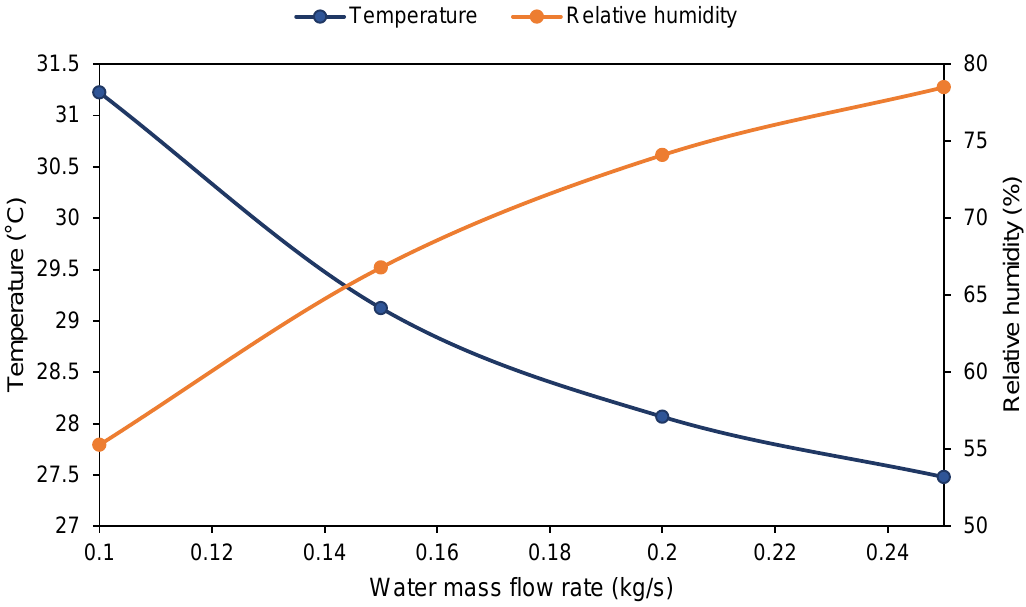
Figure 21. The influence of the water mass flow rate on the temperature reduction (ambient T = 40 °C, RH = 24.5%, U HWC = 4.4 m/s).